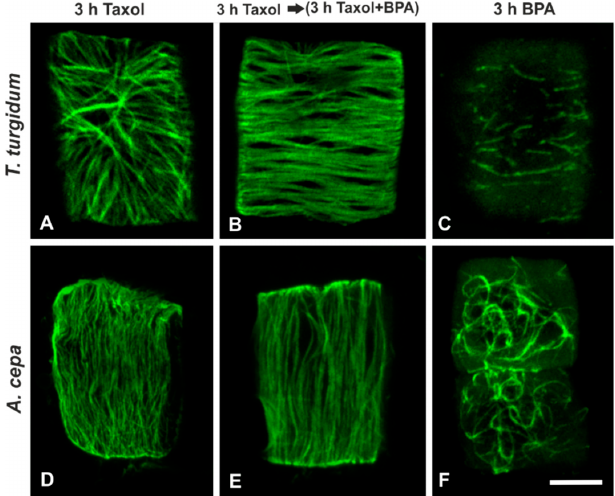
Figure 7. Maximum projections of CLSM sections, after tubulin immunolocalization in interphase root cells treated with taxol and/or BPA (as noted on images A – F ). Scale bar: 10 μ m.